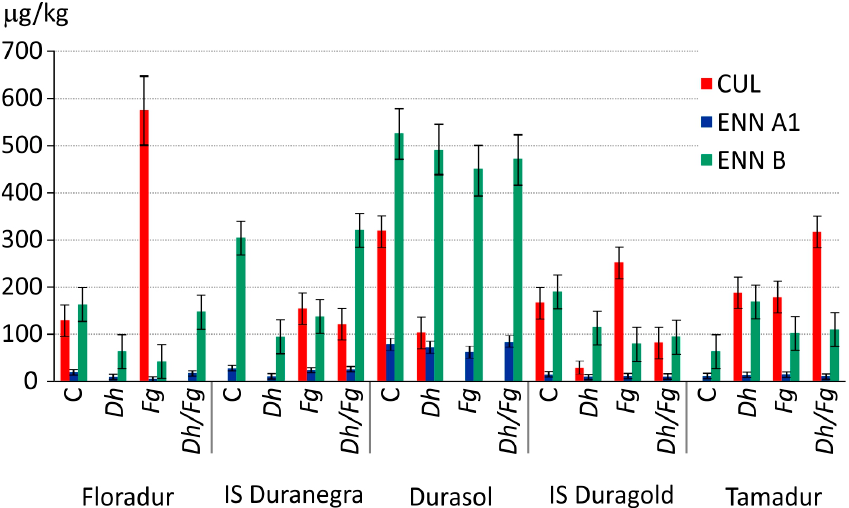
Figure 3. The levels of the CUL, ENN A1, and ENN B (µg/kg) (including the error bars) in the grain of five T. durum cultivars. C— control- without biocontrol and pathogen, Dh —biocontrol with Debaryomyces hansenii , Fg— inoculation with Fusarium graminearum, Dh/Fg— biocontrol with D. hansenii + inoculation with F. graminearum.